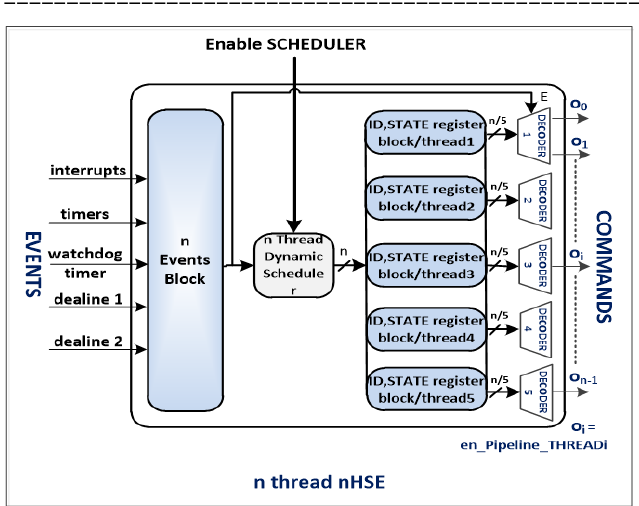
Fig. 6. Architecture of hardware scheduler engine with enable oi signals and interrupt handling model [30].